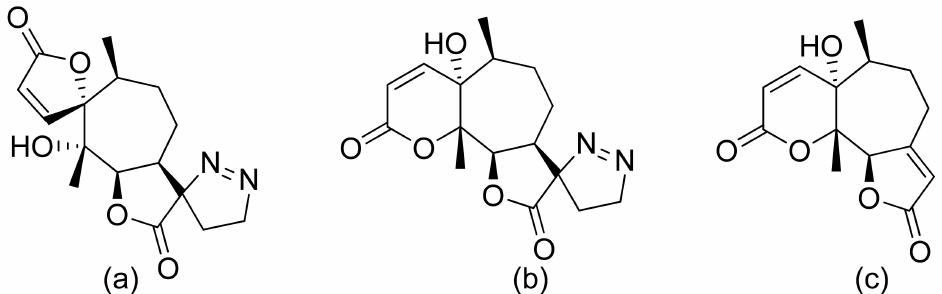
Figure 13. Psilostachyin derivatives ( a – c ). 11 α -13-Dihydrohelenalin ester derivatives from Arnica flowers were tested for their croton oil-induced mouse ear edema inhibitory activity. The percent inhibition ranged from 54% to 77% the underlying mechanisms were analyzed for Arnica flower